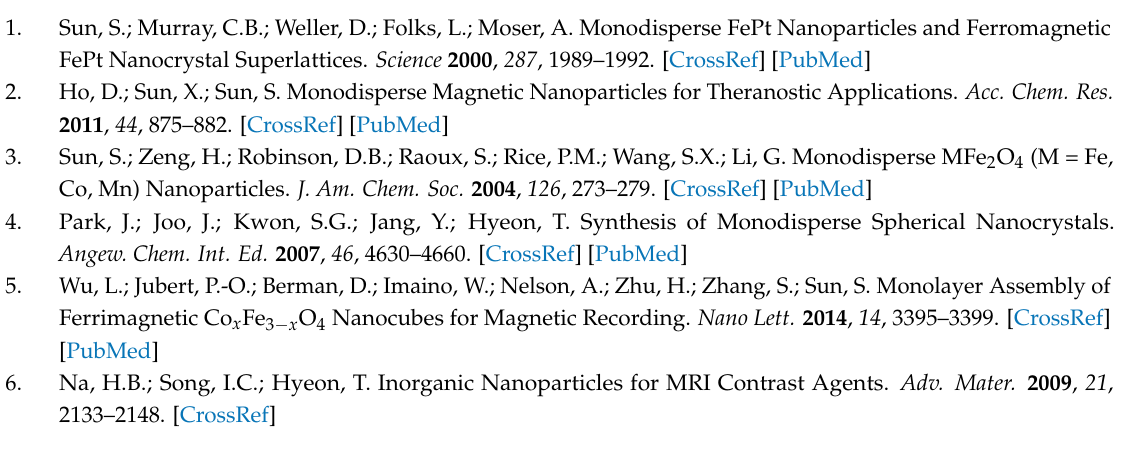
Figure S1: XRD measurement confirmed the crystalline structure of magnetite nanoparticles with two samples from initial stage (red line, 200 ◦ C, 0 min) and final state (black line, 200 ◦ C, 60 min) of the reaction; Figure S2: The oxidation state of iron at the outer surfaces of the synthesized nanoparticles was further investigated by XPS. While the complex structure of nanoscale samples prevents us from performing a full quantitative deconvolution of the Fe 2p spectra, the main Fe 2p peaks (black arrows) with the characteristic peak profile are observed for two samples which was heated at 200 ◦ C and 250 ◦ C respectively and indicates that the surface of the NPs is predominantly Fe 3+ . A satellite feature at 718.5 eV (blue arrow) is clearly observed for 250 ◦ C heating condition and this satellite is most pronounced for pure Fe 2 O 3 and is not observed for pure Fe 3 O 4 ; Figure S3: Energy Dispersive Spectroscopy (EDS) analysis of synthesized magnetite nanoparticles which was cleaned with a mixture of toluene/ethanol several times. No alkaline metal element was detected; Figure S4: TGA of Fe 3 O 4 nanoparticles synthesized with assistance of alkaline metal reagents; Figure S5: ZFC-FC measurement of different size of magnetite nanoparticles; Figure S6: Low magnification TEM images of magnetite nanocubes assisted by alkaline metal ions reductions. Various reagent concentration and reaction time enable the size control of magnetite nanocubes with the size distribution of (a) 22 ± 1.2 nm, (b) 36 ± 2.5 nm, and (c) 57 ± 5.1 nm in edge length. Scare bar is 50 nm; Figure S7: XRD measurement of Fe 3 O 4 nanocubes confirmed as inverse spinel cubic structures; Figure S8: Energy Dispersive Spectroscopy (EDS) analysis of synthesized magnetite